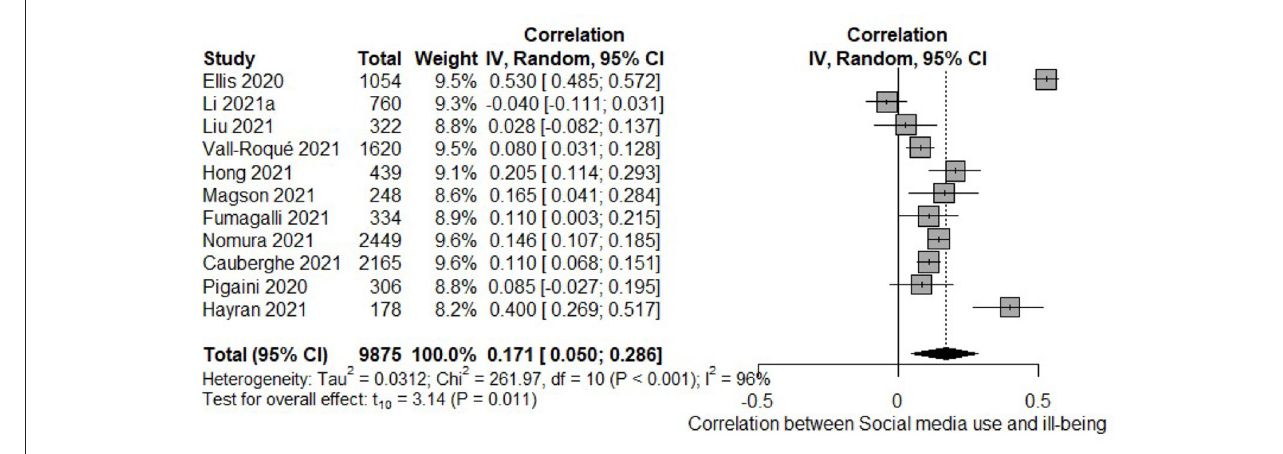
FIGURE 4 | Forest plot of the meta-analysis of social media use and ill-being.